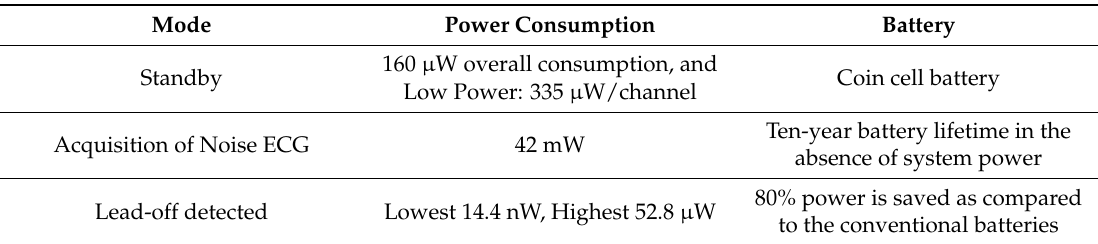
Table 1. Power consumption of different